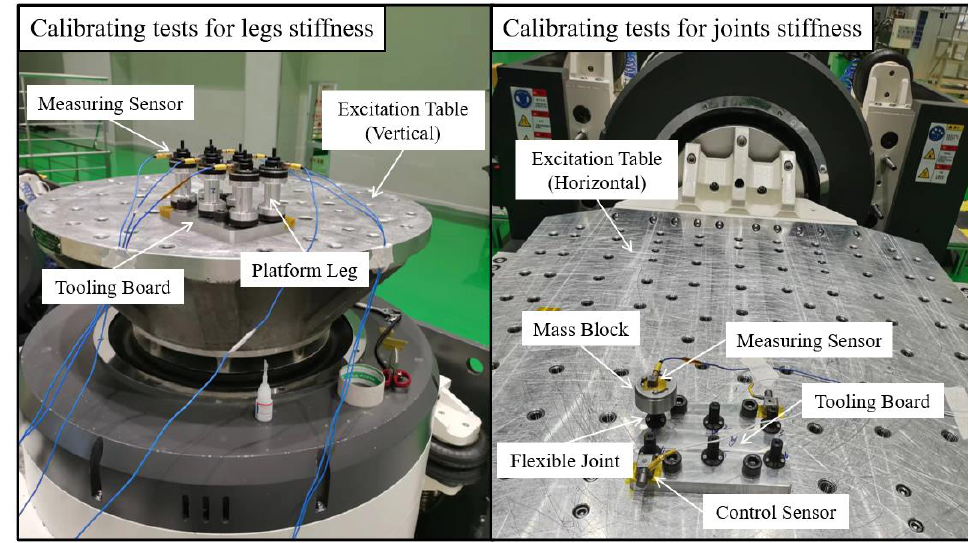
Figure 6. Stiffness calibration test of flexible components.